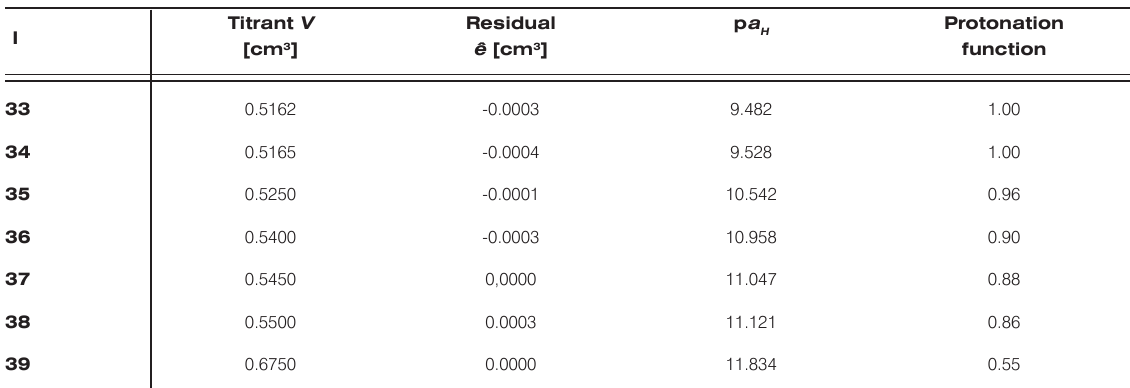
Table 4b. Reliability of estimated parameters proved by a statistical analysis of residuals. Bias, E (ê) Lower and upper Hoaglin’s limits